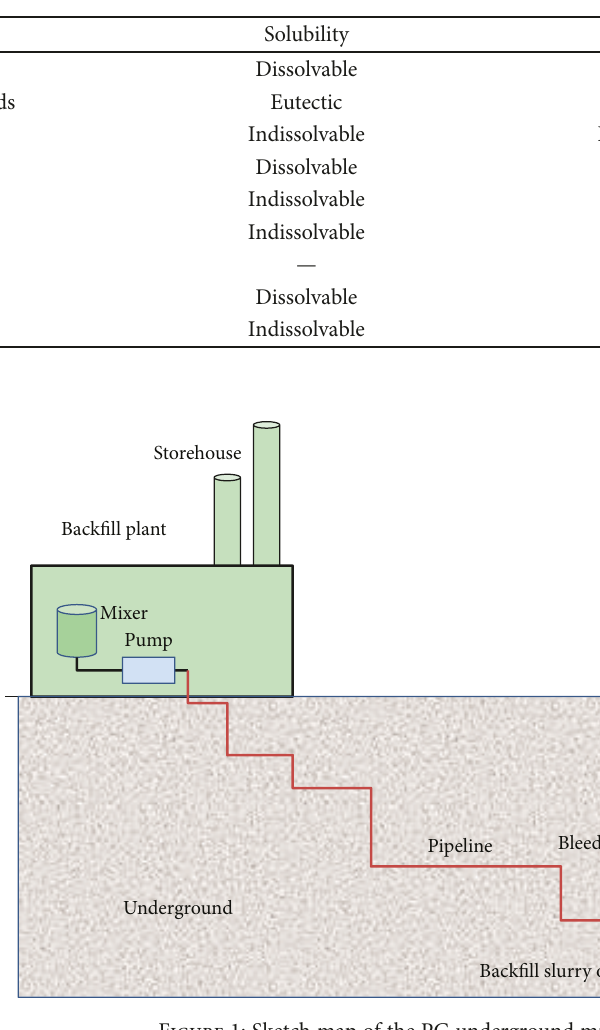
Table 1: Main impurity content distribution in PG [4].